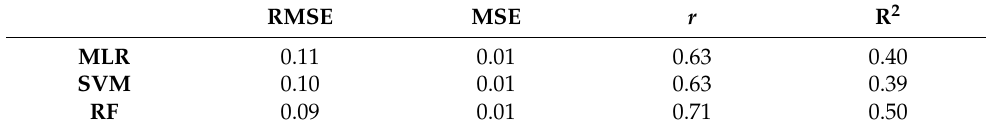
Table 3. Performance metrics of the machine learning models used in the study. RMSE MSE r R 2 MLR 0.11 0.01 0.63 0.40 SVM 0.10 0.01 0.39